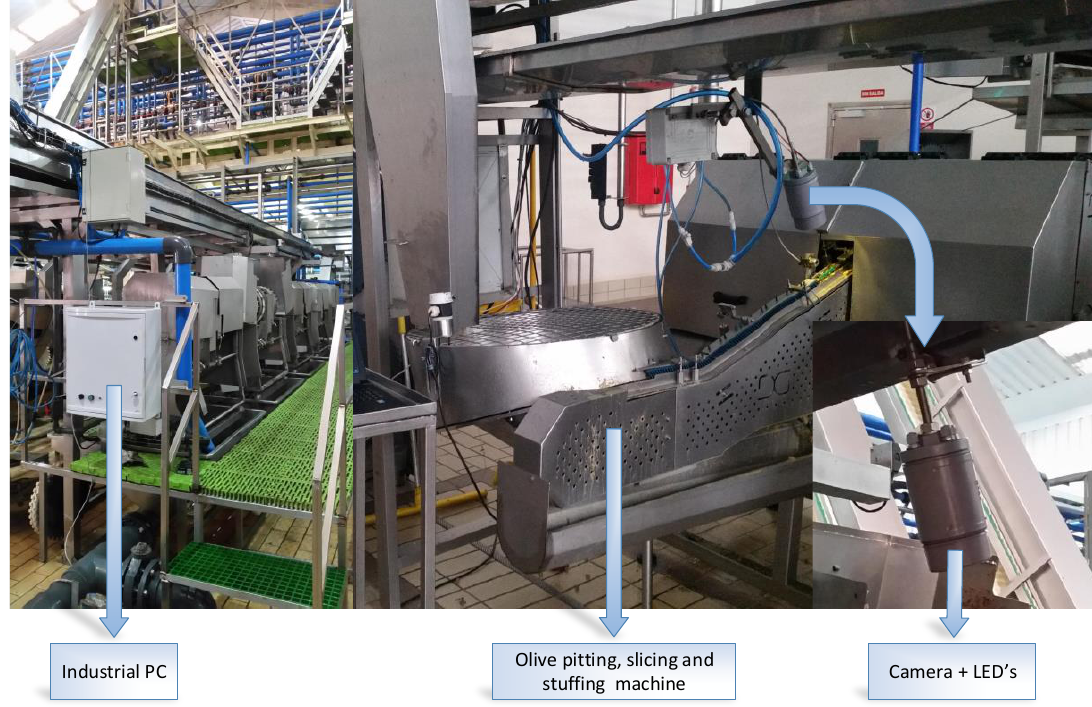
Figure 9. The system implemented on a “DRR machine”.